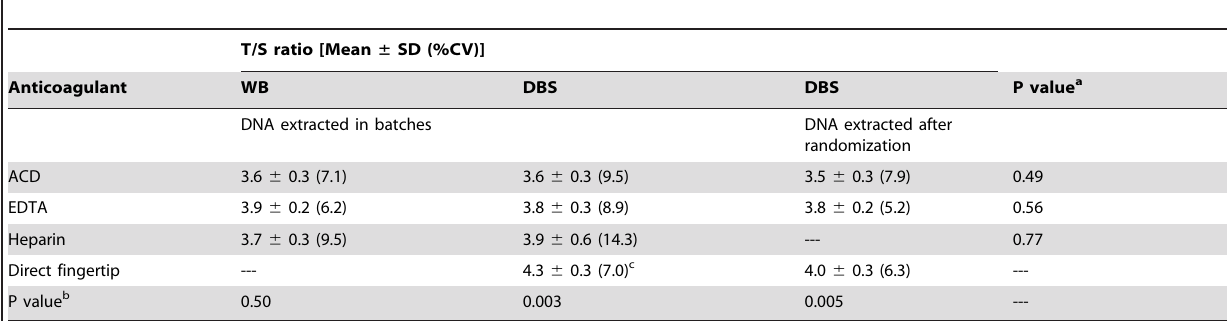
Table 2. Relative T/S ratio (n=10) measured in WB collected by venipuncture in various anticoagulants and DBS samples (blotted with WB or directly from the fingertip) from a single